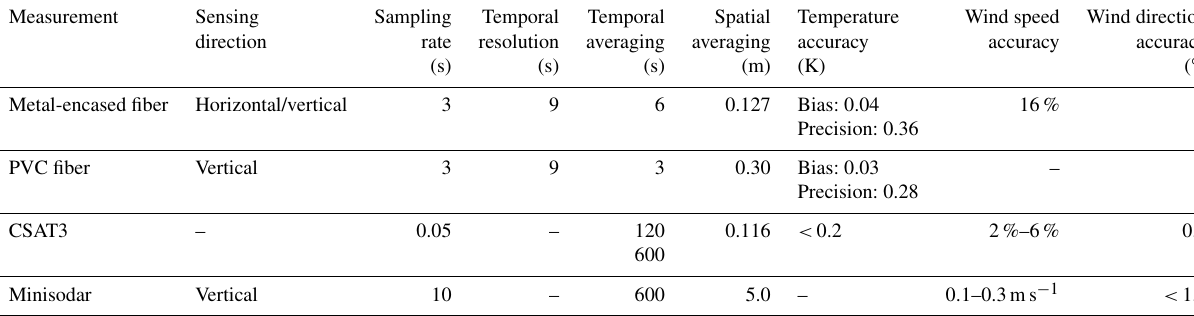
Table 1. Specifications of the measurement techniques: sampling rate, temporal resolution and averaging, spatial averaging, and accuracy of the measurements. The accuracy of the minisodar and CSAT3 wind measurements were taken from their manuals. The accuracy of the CSAT3 temperature measurements was calculated by Fritz et al. (2021). The accuracy of the temperature measured by FODS is based on the readings in the calibration baths: the bias is defined as the standard deviation of the daily averaged differences between the fiber and reference (PT100) temperatures in each bath; the precision is defined as the median of the daily spatial standard deviation of fiber temperatures within each bath. The accuracy of the fiber wind speed is computed as the standard deviation of the fractional absolute deviation of the fiber readings from those of the reference (CSAT3) instrument aggregated to 30s. The bias systematically depends on the location along the fiber and ranges from an 8% underestimation to a 13% overestimation with an average overestimation of 4%. Measurement Sensing Sampling Temporal